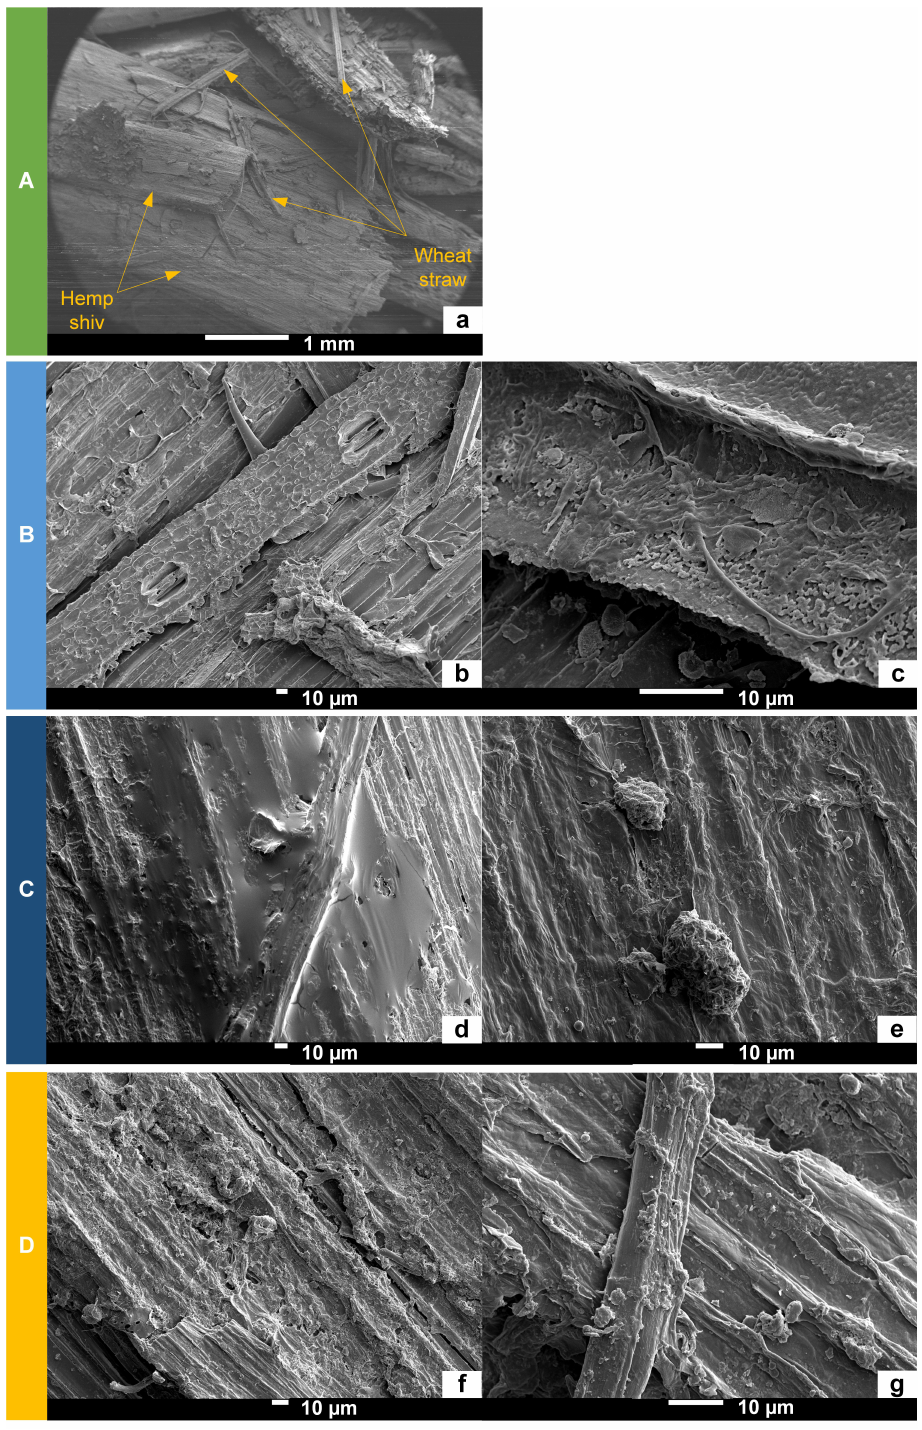
Figure 8. SEM micrographs at the interface between the hemp shiv and the binder: ( a ) composite A, ( b , c ) composite B, ( d , e ) composite C, ( f , g ) composite